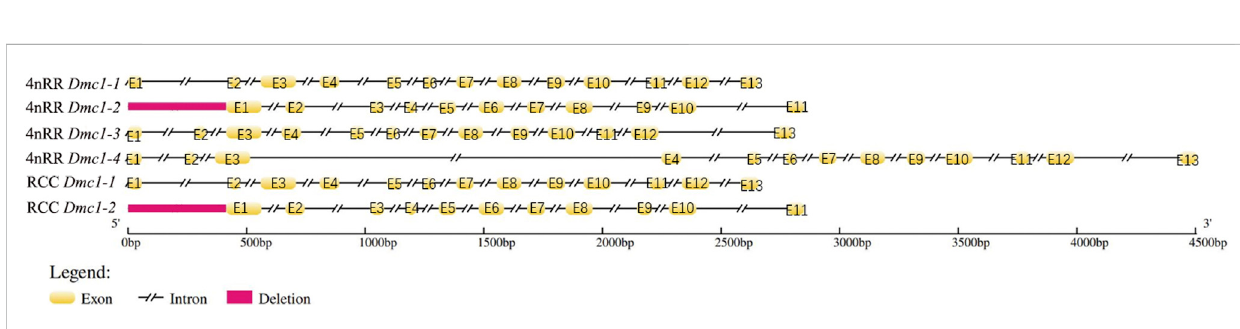
FIGURE 2 DNA structure character of the Dmc1 genes in RCC and